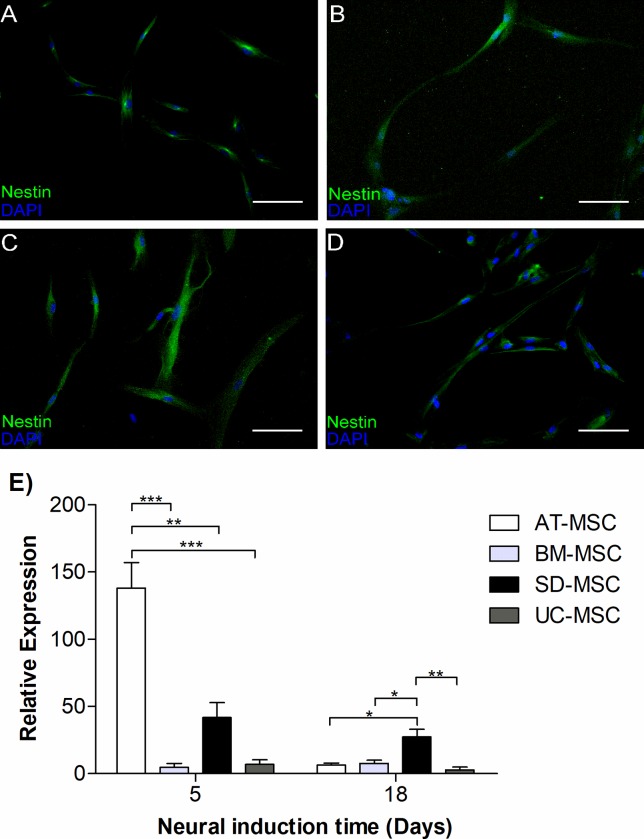
Nestin expression in induced MSC.Nestin relative expression in AT-MSC, BM-MSC, SD-MSC and UC-MSC after
neural induction. (A, B, C, D) Immunocytochemistry
analysis of nestin at day 5 of neural induction; (A)
AT-MSC, (B) BM-MSC, (C) SD-MSC,
(D) UC-MSC. Nestin marker expression (green) and
nuclei (Blue), scale bar 100 μm. E) Time dependent
expression of nestin assessed by RT-PCR. Data is
presented as an average of three independent patient samples and
error bars represent mean ± SEM, ns P> 0.05, * P <0.05, ** P
<0.01, *** P <0.001.